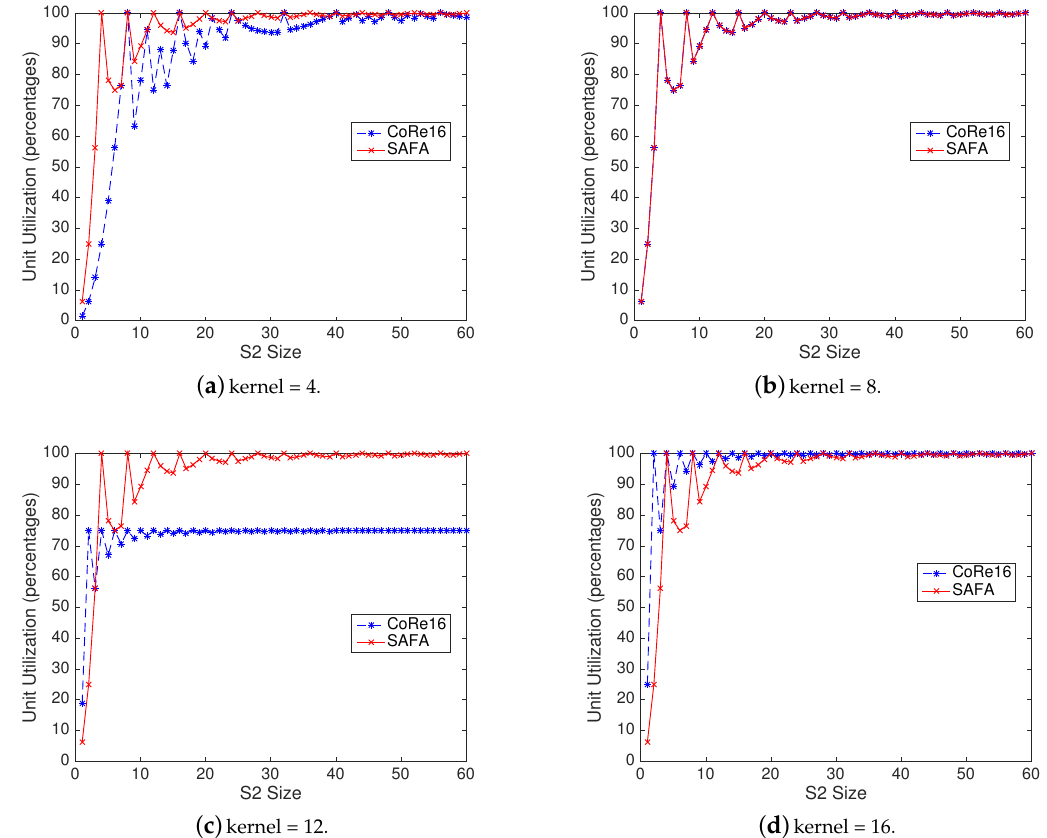
Figure 8. Unit utilization comparison for SAFA and CoRe16. SAFA performs well with a larger S2 size and reaches nearly 100% unit utilization under different kernels. This is because SAFA works more times at full load with a lager S2 size, resulting in fewer unused